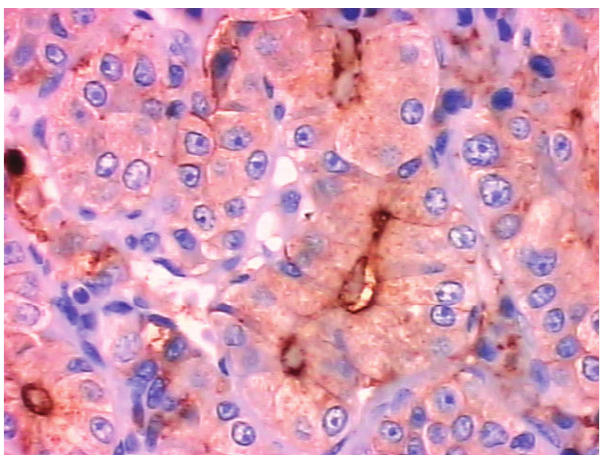
Figure 2, Panel C. Immunohistochemistry shows positive staining of the tumor cells and bile canaliculi with carcinoembryonic antigen (magnification, 400x).